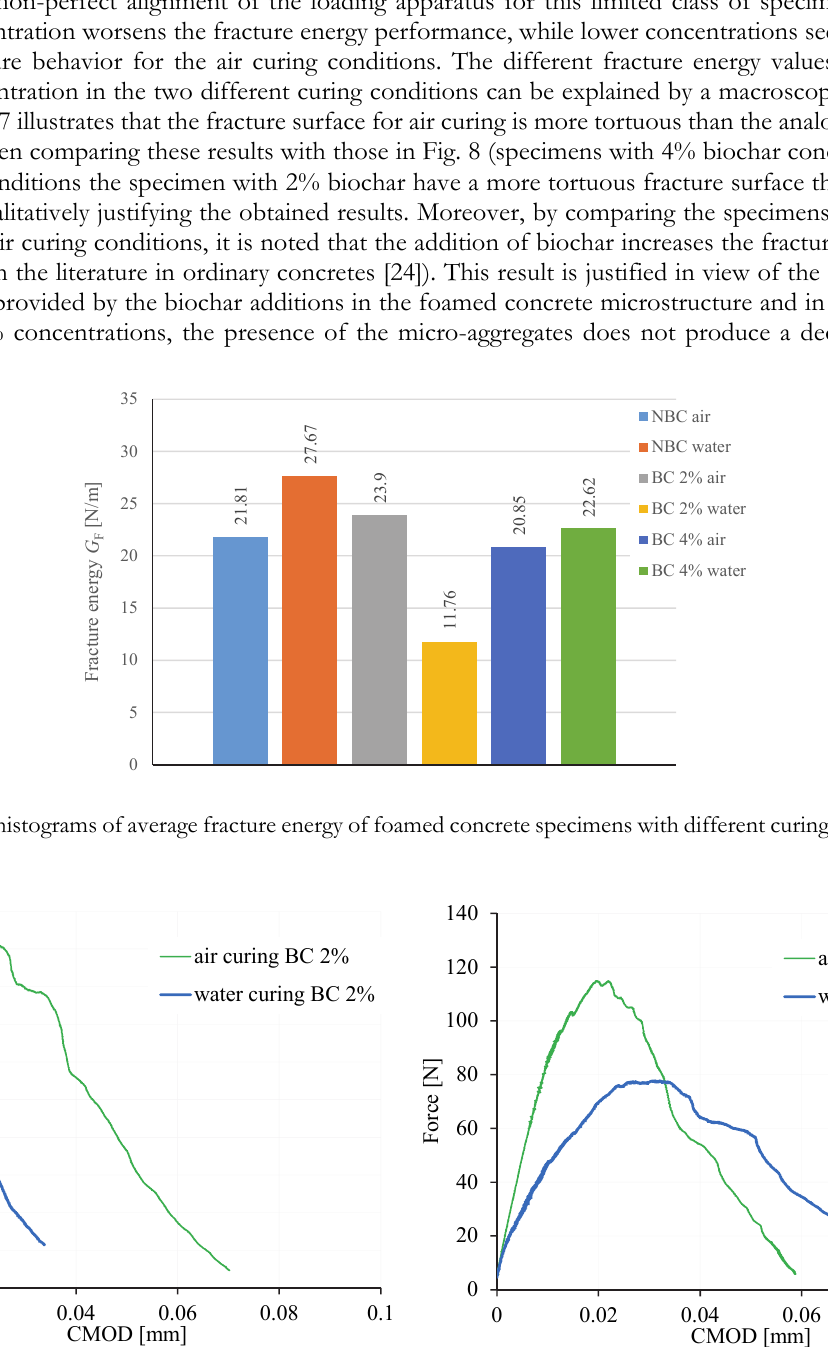
Figure 6: Force displacement curves of foamed concrete specimens with different curing conditions and biochar content of 2% (left) and 4% (right) of the cement